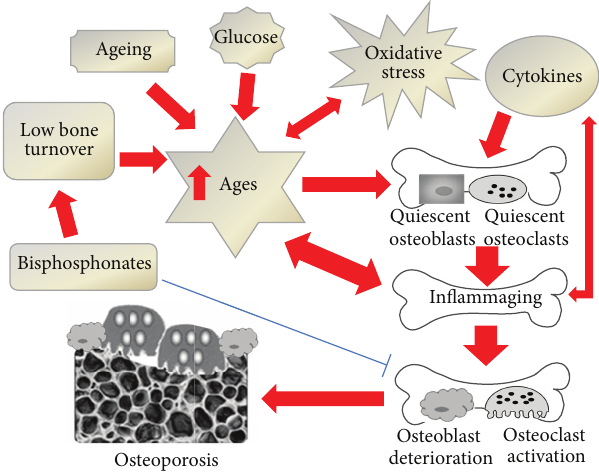
Figure 1: The vicious circle linking inflammation and aging results in the accumulation of AGEs within the osteoporotic bone. Oxida- tive stress, high glucose, aging processes, and low bone turnover conditions contribute to an increased formation and accumulation of AGEs in bone, where they trigger a low level of chronic inflamma- tion defined as “Inflammaging.” Together with an increase of certain proinflammatory cytokines, AGEs induce both the activation of osteoclastogenesis and osteoblast dysfunction; these processes lead to an accelerated development of osteoporosis. The use of bispho- sphonates might have a dual effect: it inhibits osteoclastogenesis by improving the bone resorption, but it slows the bone turnover, increasing the accumulation of AGEs and potential long term adverse